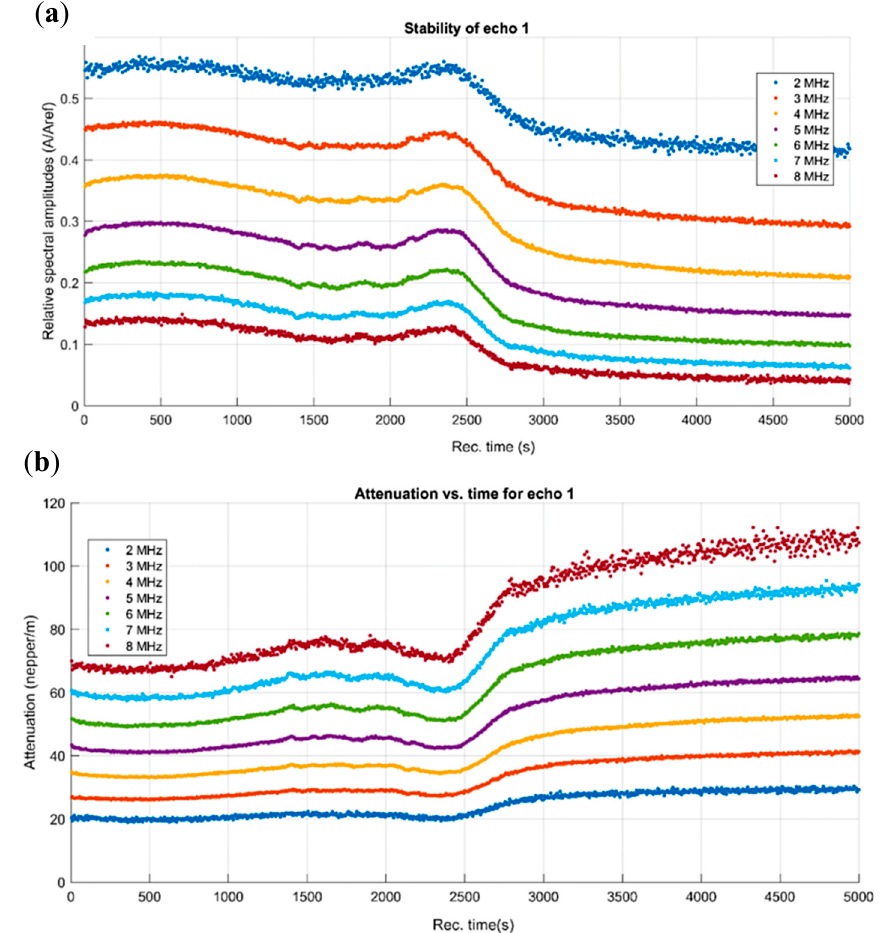
Figure 2. Spectral amplitudes relative variation vs. time, for the first echo ( a ); Attenuation vs. time for the spectral components of echo 1 ( b ).